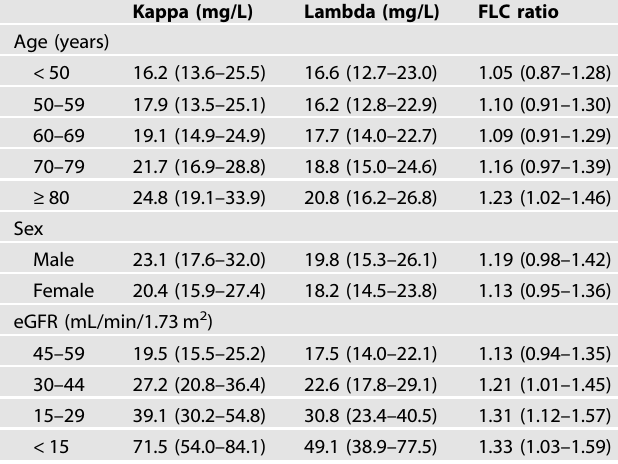
Table 2. Median (IQR) levels of serum kappa and lambda FLC and FLC ratio in subgroups according to age, sex, and categories of reduced estimated glomerular fi ltration rate.